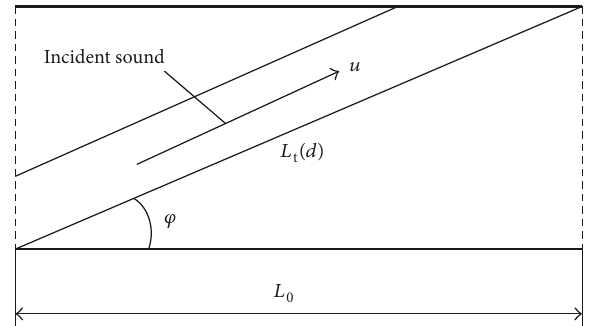
Figure 4: Schematic illustration of the PFMM with pores of constant and equal radius, with respect to the normal of surface.